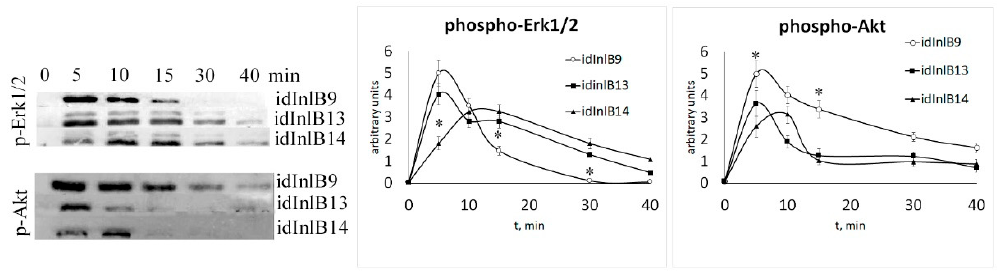
Figure 2. Kinetics of Erk1/2 and Akt phosphorylation in the presence of idInlBs. A total of 100 ng/mL idInlBs were added to HEp-2 cells. Cells were lysed at pointed time points and probed with anti-phospho-Erk1/2 and anti-phospho-Akt antibodies. The curves show digitized data from three independent experiments. * p < 0.05.